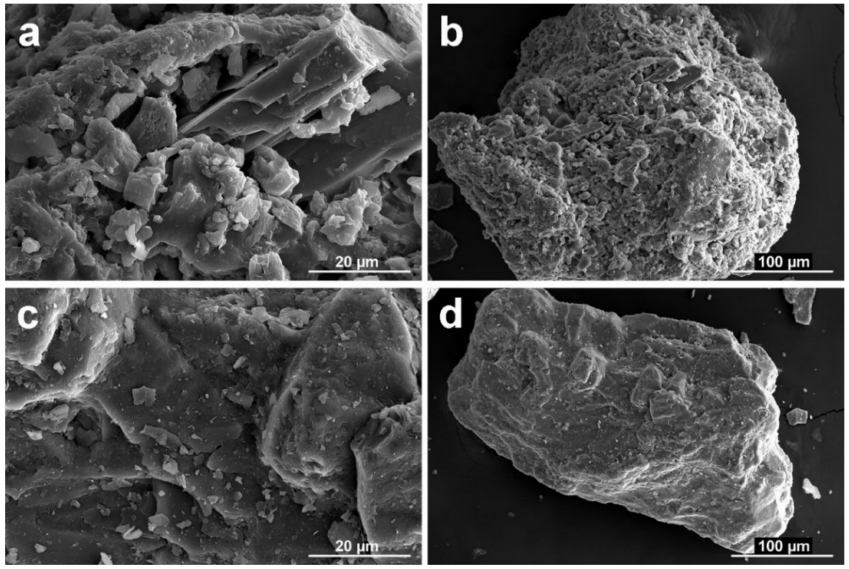
Figure 3. SEM image of RAP ( a , b ) and NSS ( c , d )